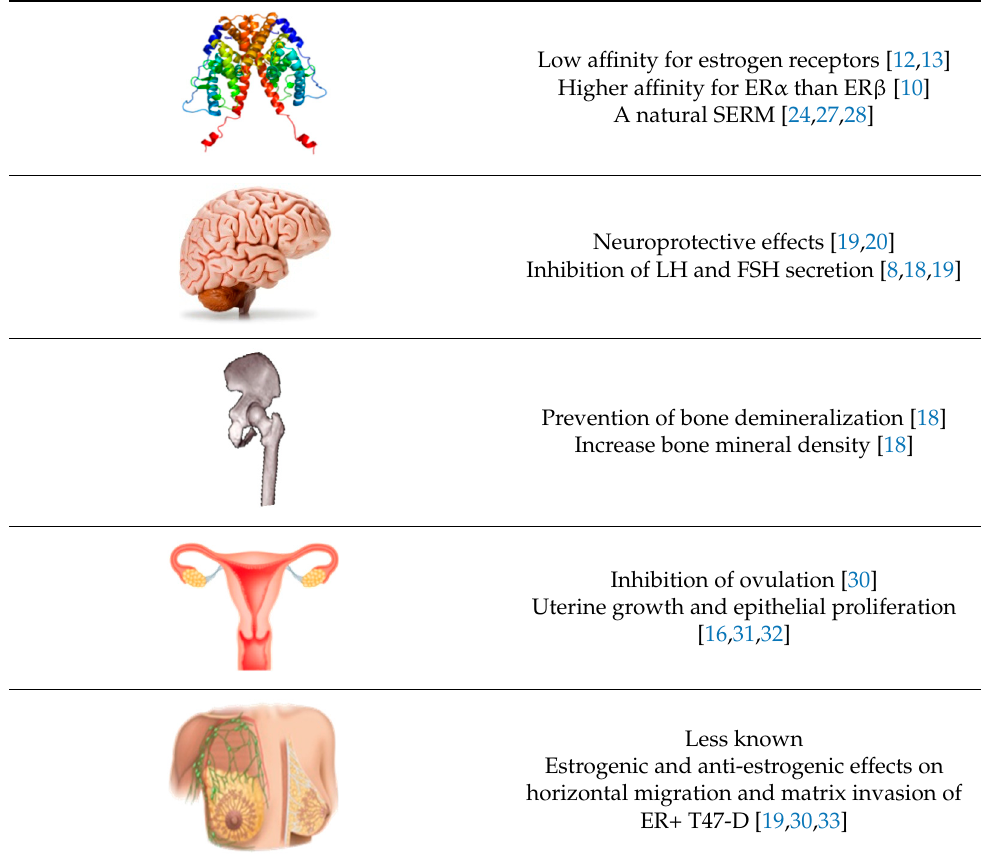
Table 1. Effects of estetrol on the estrogen receptor α (ER α ) and β (ER β ) on different tissues: brain, bone, female genital system, and breast.